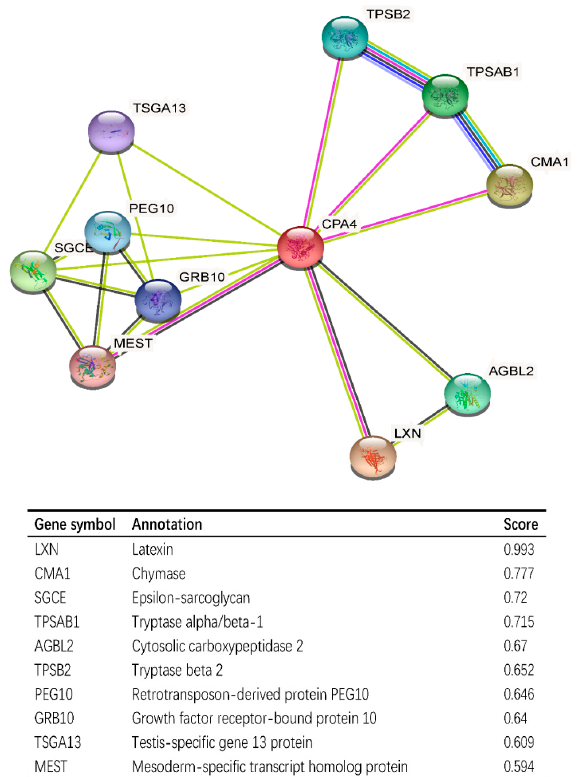
Figure 7. CPA4-interaction proteins in BLCA tissue; annotation of CPA4-interacting proteins and their co-expression scores.